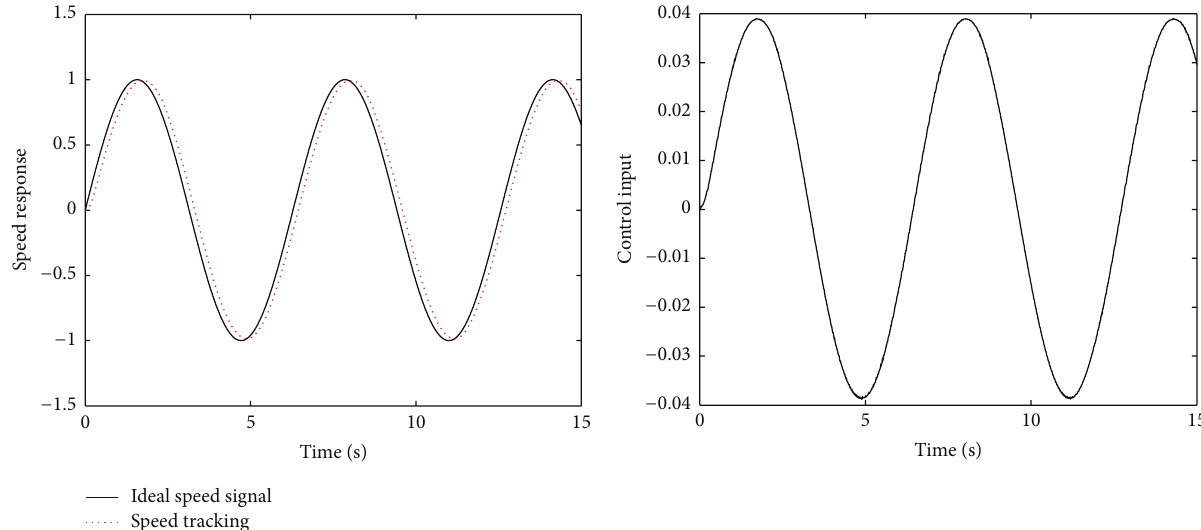
Figure 20: Simulation curve based on fuzzy sliding mode control at variable speed.